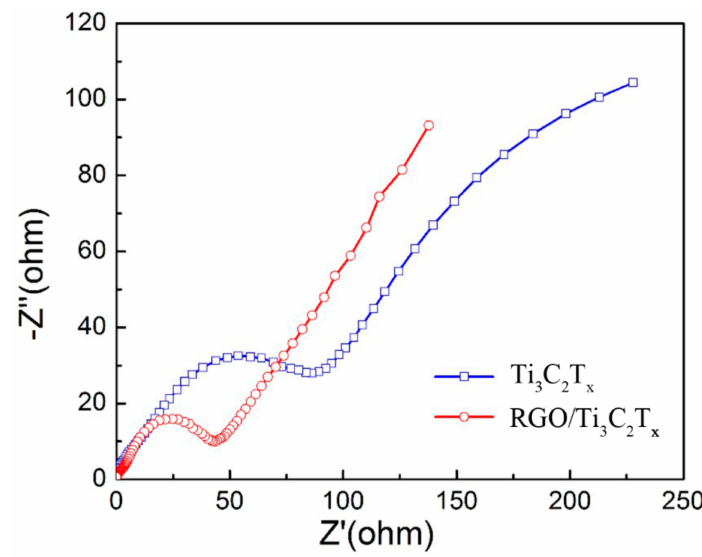
Figure 9. Electrochemical impedance spectroscopy (EIS) plots of the Ti 3 C 2 T x and RGO/Ti 3 C 2 T x